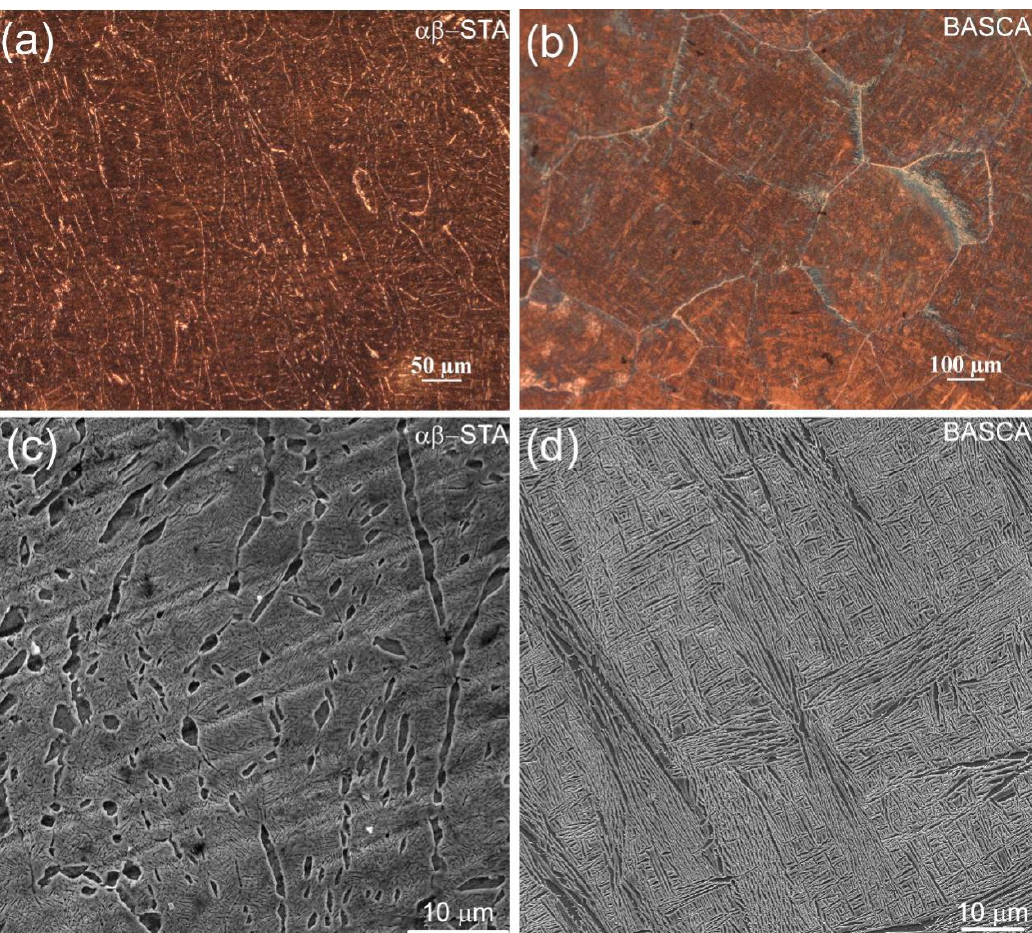
Figure 8. OM images of post-heat-treated Ti55511 alloy for: ( a ) αβ -STA and ( b ) BASCA. ( c , d ) are the corresponding SEM images.